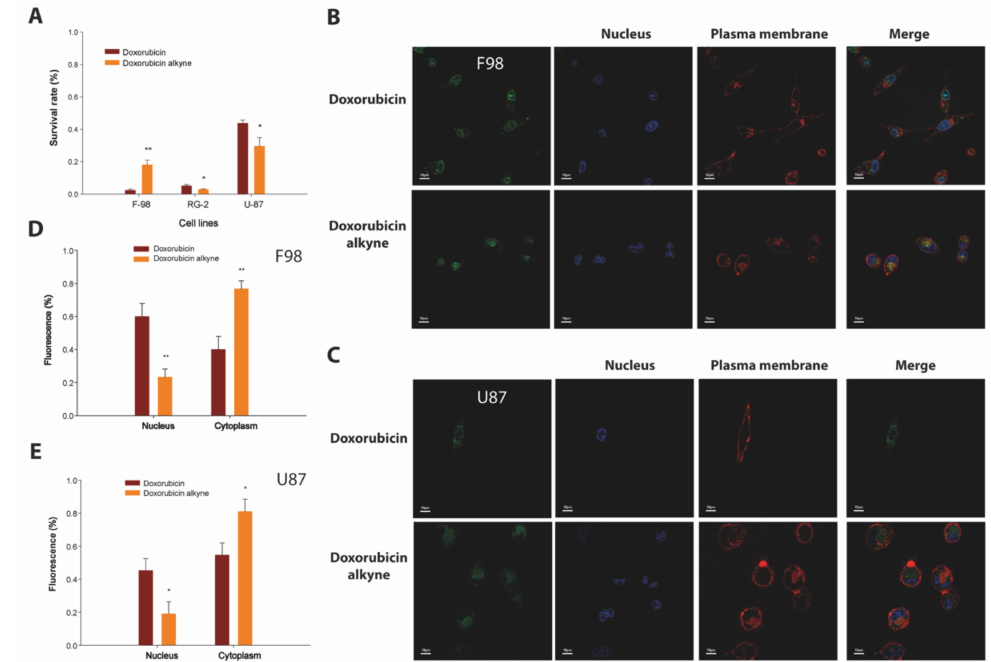
Figure 5. Cell toxicity on GBM cells and subcellular distribution of doxorubicin-alkyne. ( A ) Cell toxicity of 10 µ M of doxorubicin and doxorubicin-alkyne incubated 72 h with various cell lines. ( B ) Cell localization of doxorubicin and doxorubicin-alkyne in F98 cells at 3 µ M (2 h incubation time). Doxorubicin and doxorubicin-alkyne are shown in green. The plasma membrane is labeled with concanavalin-A-alexa fluor 647 (red color) and the nucleus with Hoechst 34,580 (blue color). ( C ) Cell localization of doxorubicin and doxorubicin-alkyne in U-87 as in ( B ). ( D ) Quantification of the cell localization of doxorubicin and doxorubicin-alkyne in F98 cells. ( E ) Quantification of cell localization of doxorubicin and doxorubicin-alkyne in U-87 cells. Scale bars in ( B , C ): 10 µ m. *, p ≤ 0.05, **, p ≤